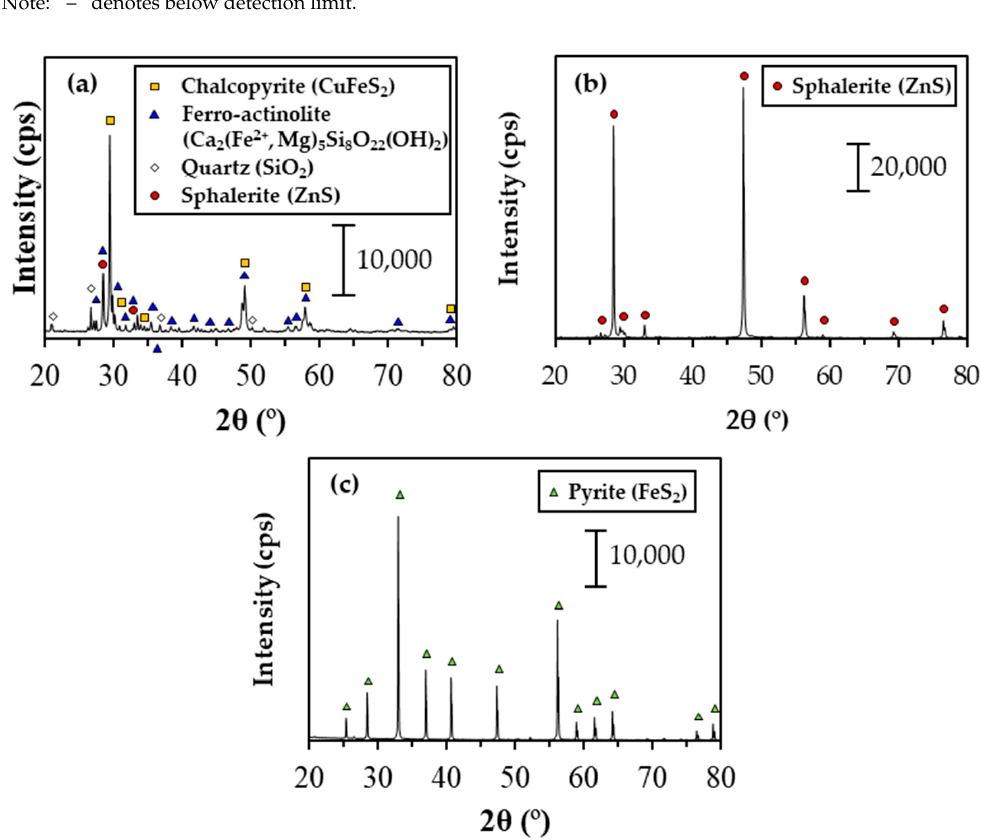
Figure 1. XRD patterns of mineral samples: ( a ) chalcopyrite (CuFeS 2 ), ( b ) sphalerite (ZnS), and ( c ) pyrite (FeS 2 ). Note differences in the scales of the y-axes.